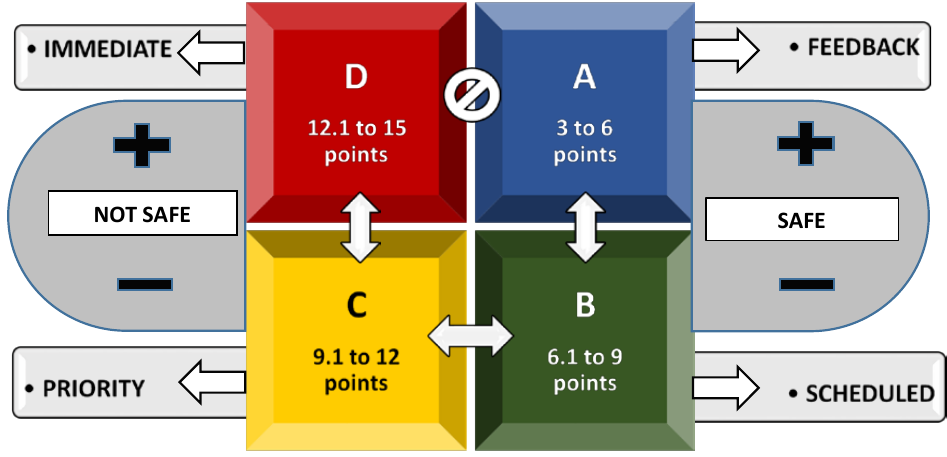
Figure 2. A Conceptual Flowchart for Priority Definition of Management Action